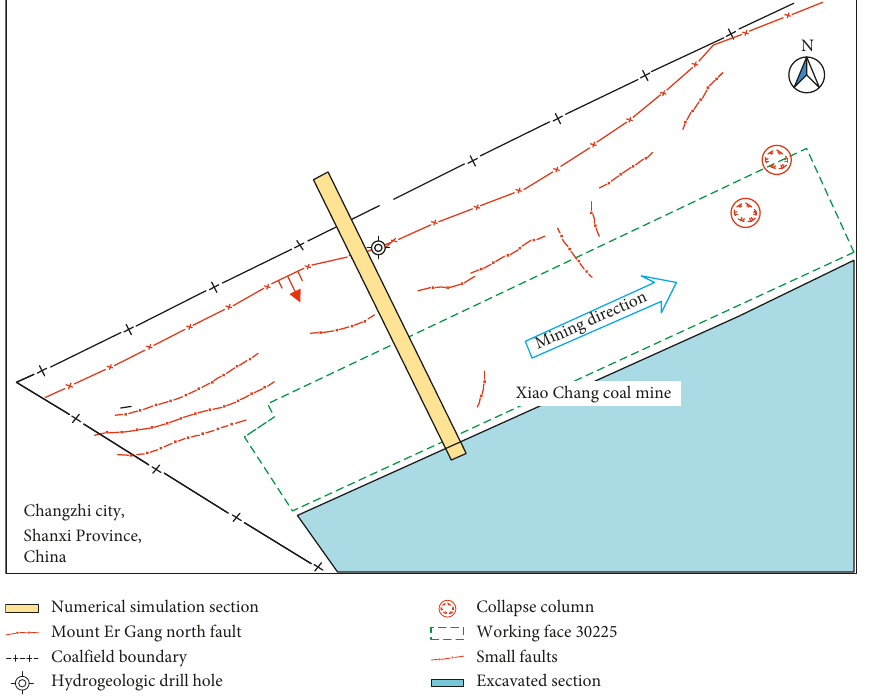
Figure 7: Engineering environment in Xiao Chang coal